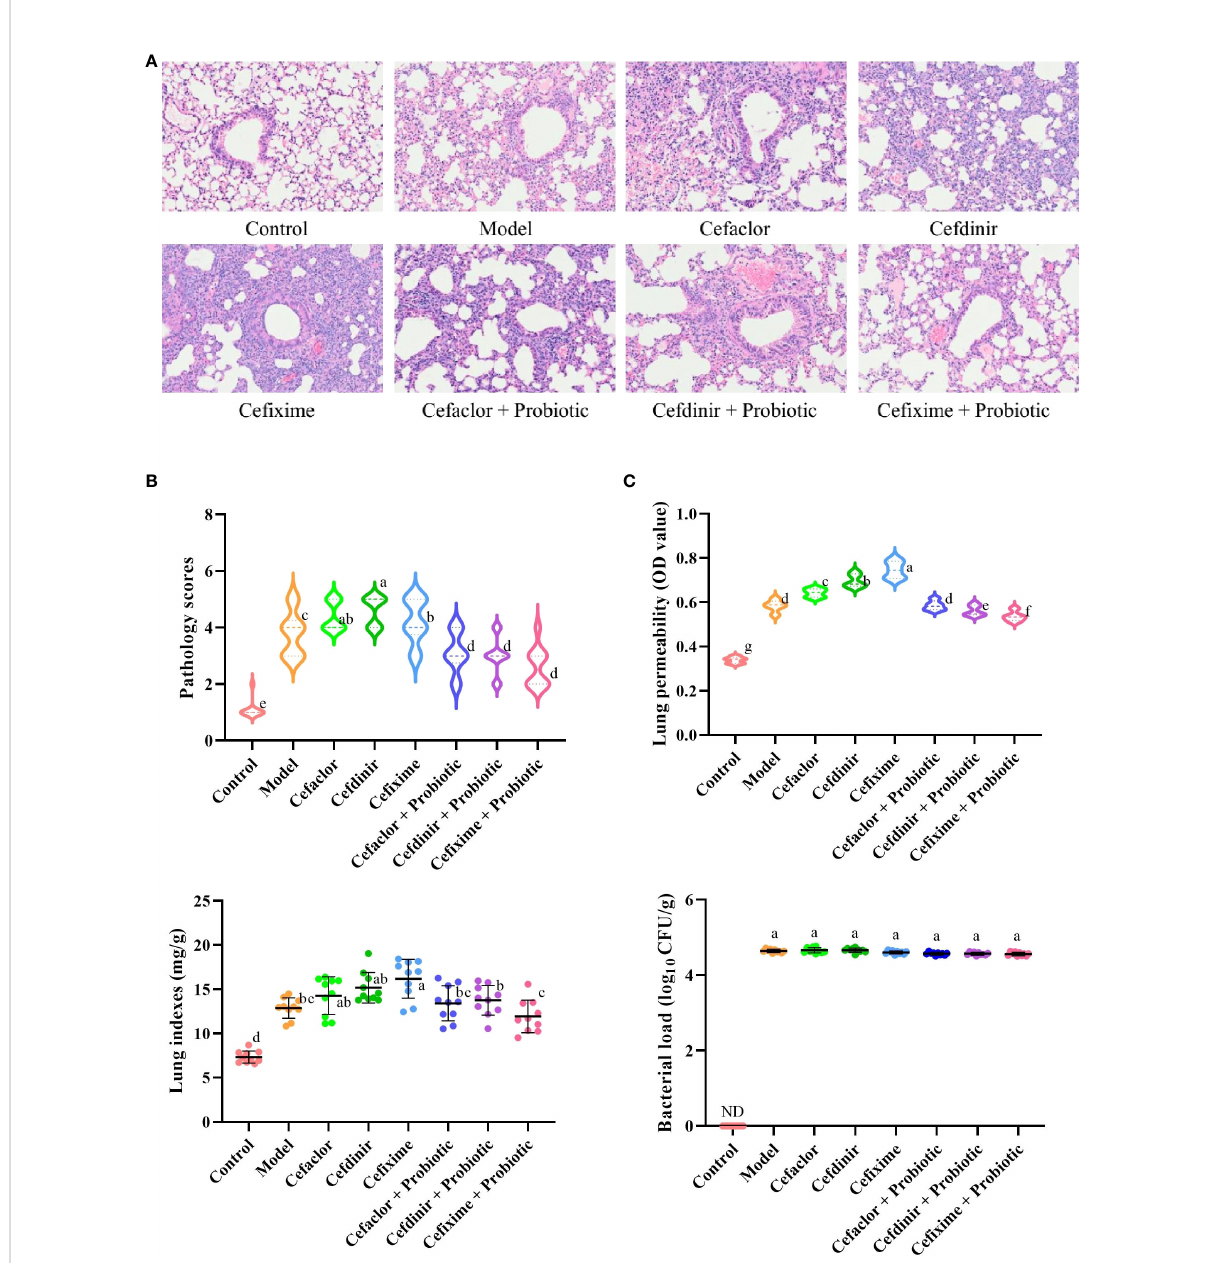
FIGURE 2 Effects of cephalosporins on Spn-induced acute lung injury in mice. (A) The histopathological features of the lung tissues in Spn-infected mice. (B) The levels of lung injury were estimated by pathological scores. (C) Effects of cephalosporins on pulmonary hyperpermeability, lung indexes and bacterial loads in infected mice. ND, not detected. Data were showed as mean ± SD. Different letters indicated statistically signi fi cant differences, P